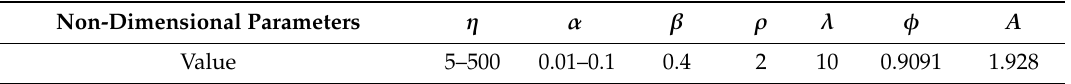
Table 1. The value of the non-dimensional parameters set for